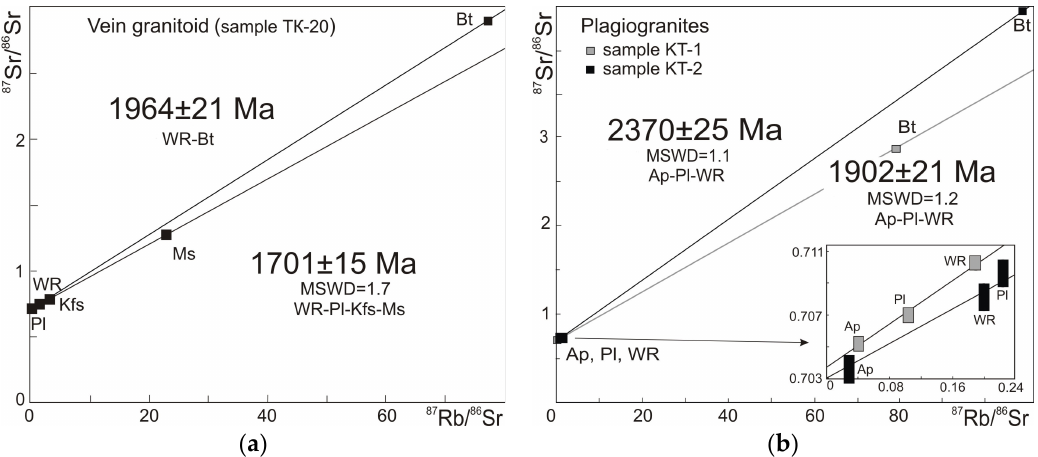
Figure 4. Rb-Sr isotope data for rocks and minerals of the Litsa area: ( a ) vein granitoid of the Dikoe ore occurrence; ( b ) plagiogranites of the Skal’noe occurrence. WR—whole rock, Pl—plagioclase, Ap—apatite, Bi—biotite, Kfs—K feldspar.